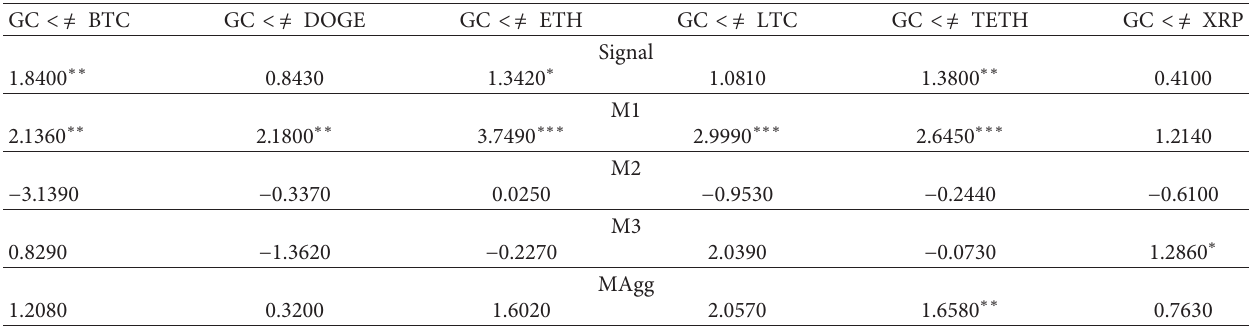
Table 10: Diks and Panchenko nonparametric causality between gold and six cryptocurrencies. GC <≠